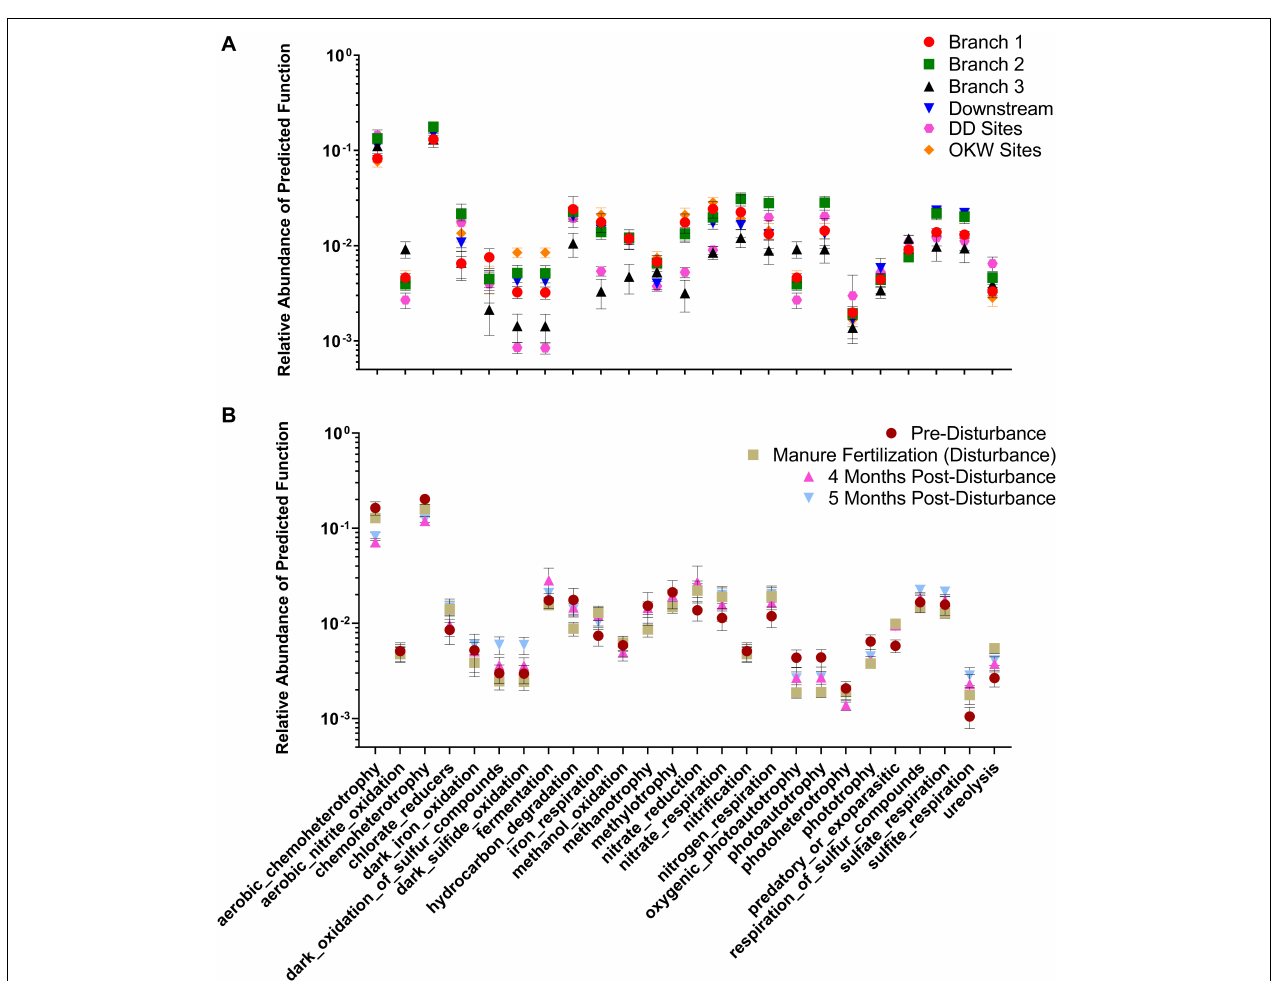
FIGURE 5 | Relative abundance of functions assigned by FAPROTAX to each sample clustered by (A) river sampling location and (B) sampling timepoint. Mean relative abundance ± standard error is shown for each cluster on a log scale.